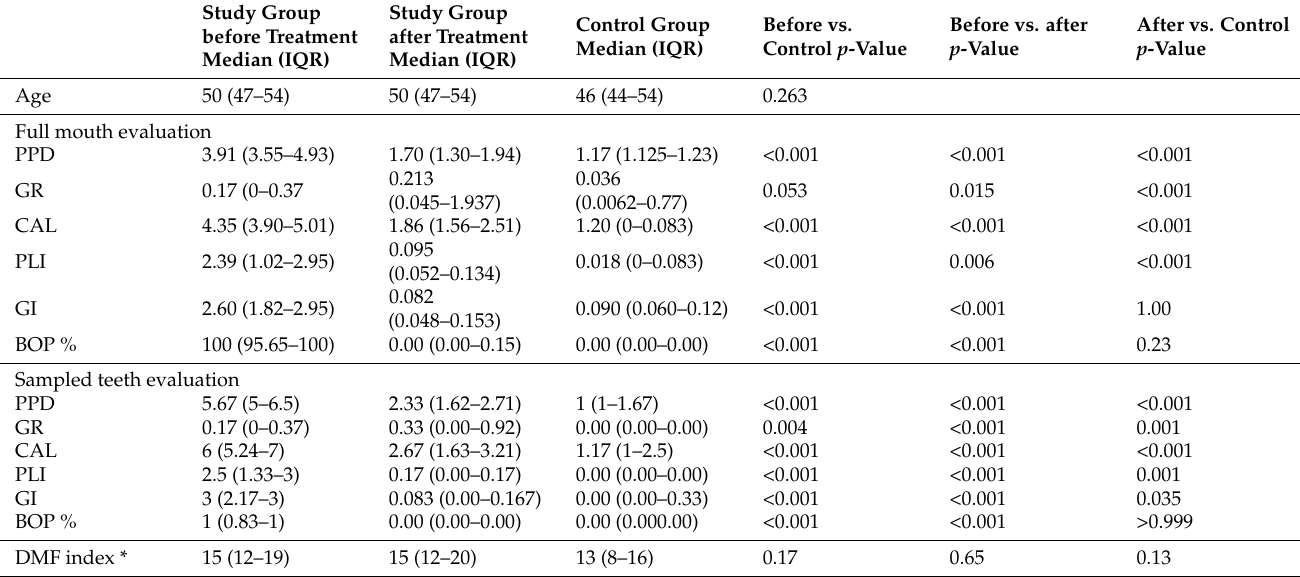
Table 1. Periodontal status of subjects included in the study.